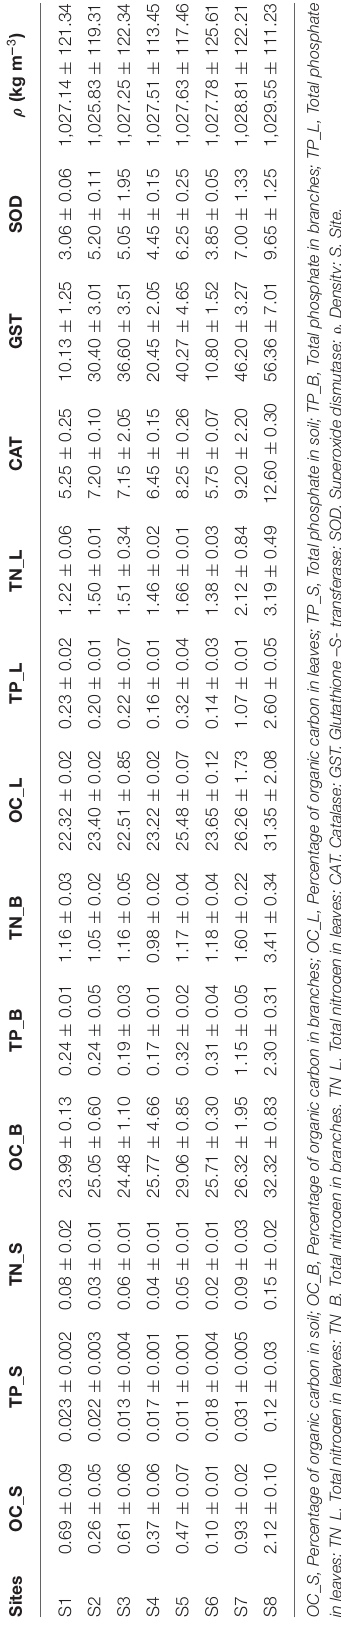
Among all sites in Rabigh Lagoon, mangroves at S1 at the lagoon entrance had the lowest CAT (5.25 µ mol/mg